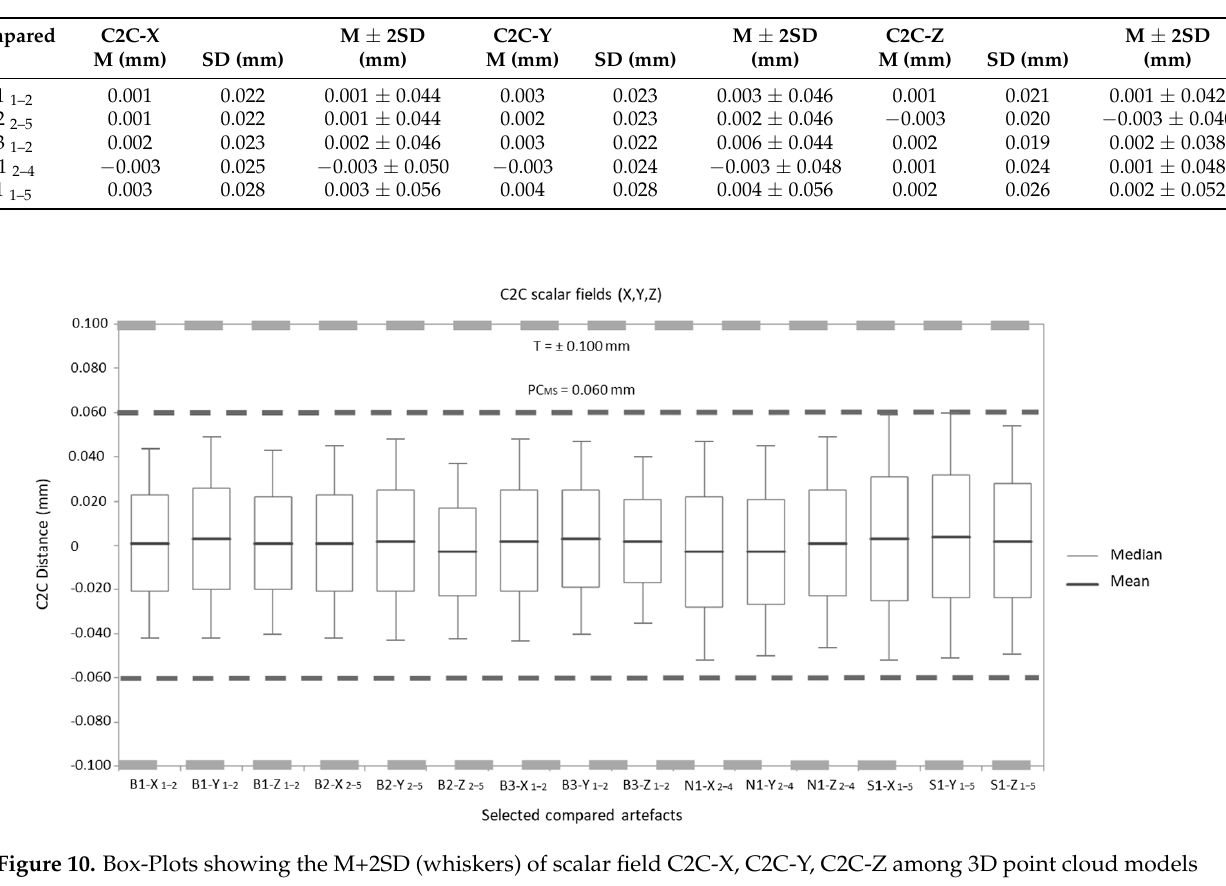
Table 6. Average distances (M) and standard deviations (SD) of C2C surface deviation analysis calculated with M±2SD on scalar fields C2C-X, C2C-Y, C2C-Z distances.